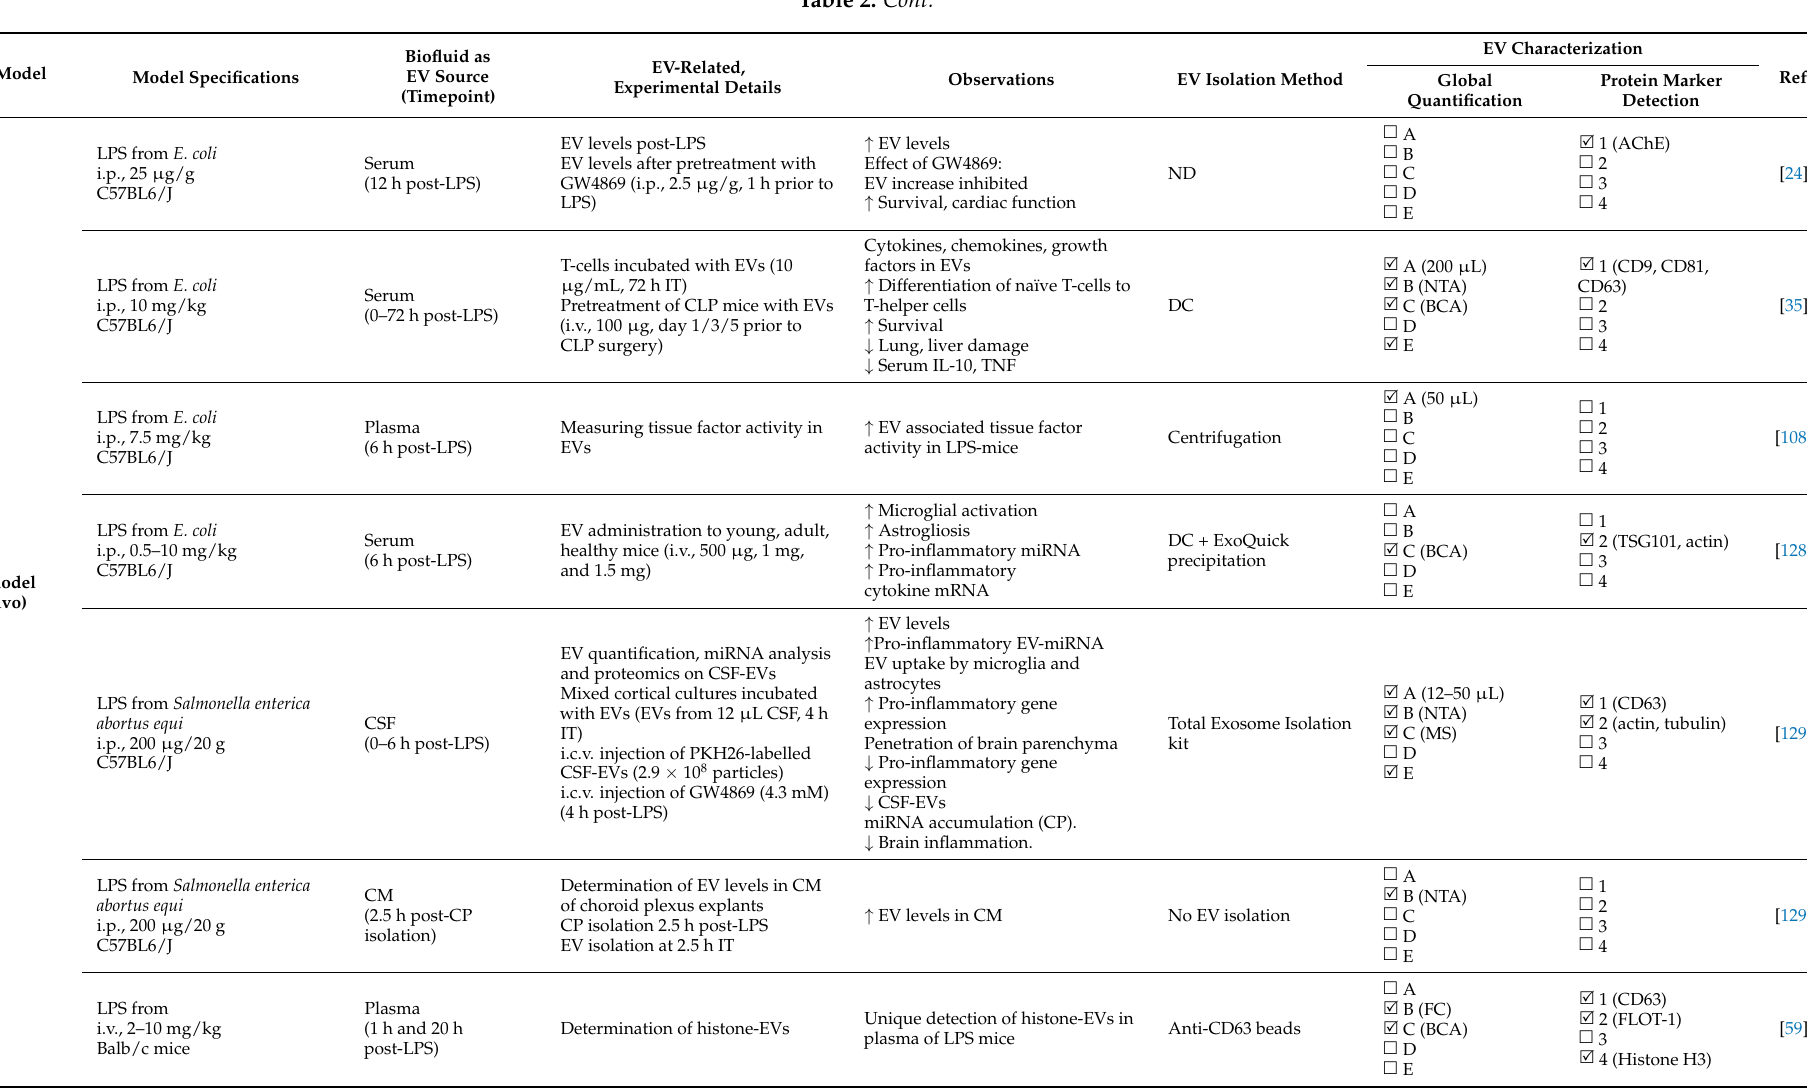
No difference in EV levels between sepsis/septic shock patients and healthy donors.